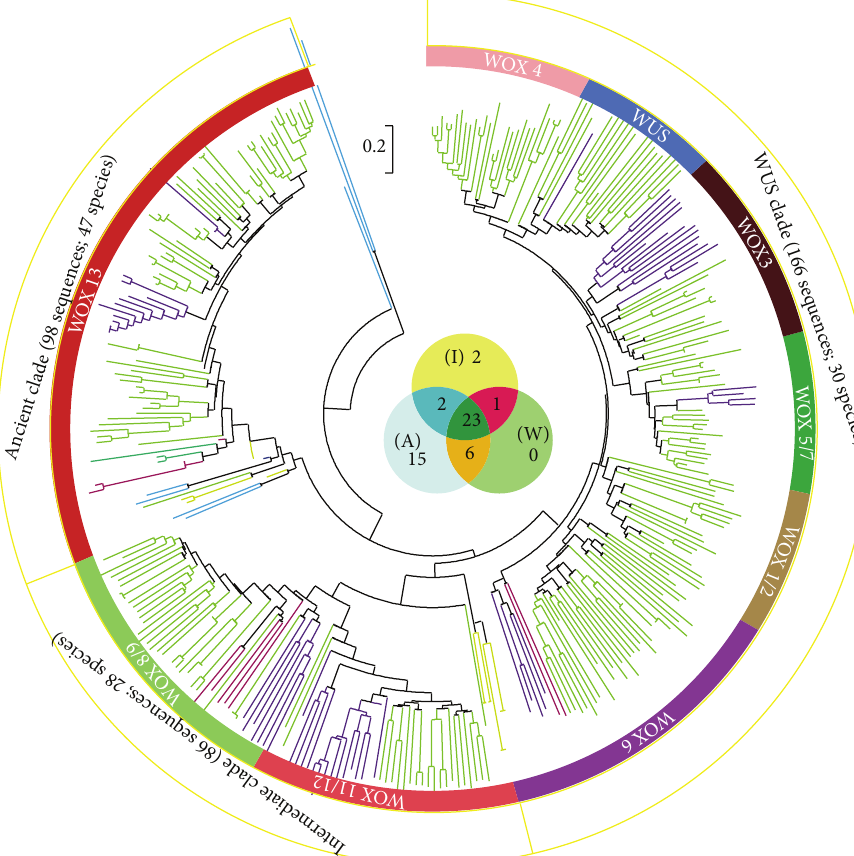
Figure 4: Phylogenetic analysis of WOX family. A simplified version of the neighbor joining (NJ) tree, with 350 sequences of proteins from 50 species from green algae to angiosperms. The tree was divided into three clades. The three clades were the WUS clade, containing 166 sequences, 30 species; the intermediate clade, containing 86 sequences, 28 species; the ancient clade, containing 98 sequences, 47 species. The full phylogeny is shown in Supplementary Figure3. In the inset, (A), (I), and (W) refer to the ancient clade, the intermediate clade, and the WUS clade. Two species ( P . staeda and S . moellendorffii ) have members in both ancient clade and intermediate clade; one species ( P . hybieda ) has members in both intermediate clade and WUS clade; six species ( B . rapa , Gossypium hirsutum , P . sitchensis , R . sativus , Solanum tuberosum , and Vigna unguiculata ) have members in both ancient clade and WUS clade; twenty-three species have members belonging to three clades. The species names are shown in Supplementary Table